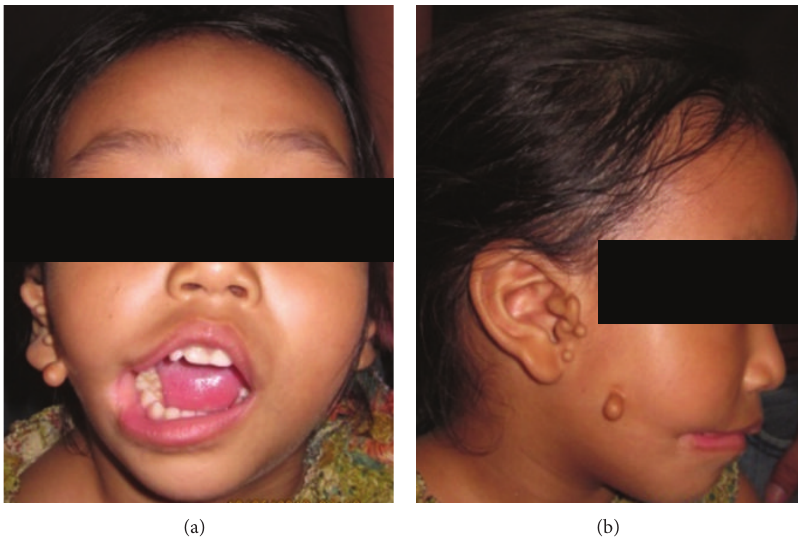
Figure 1: Preoperative photographs showing the frontal and lateral view of the patient.